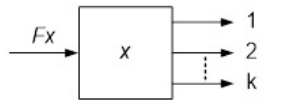
Figure 4. Virtual device with one entrance and k exits.